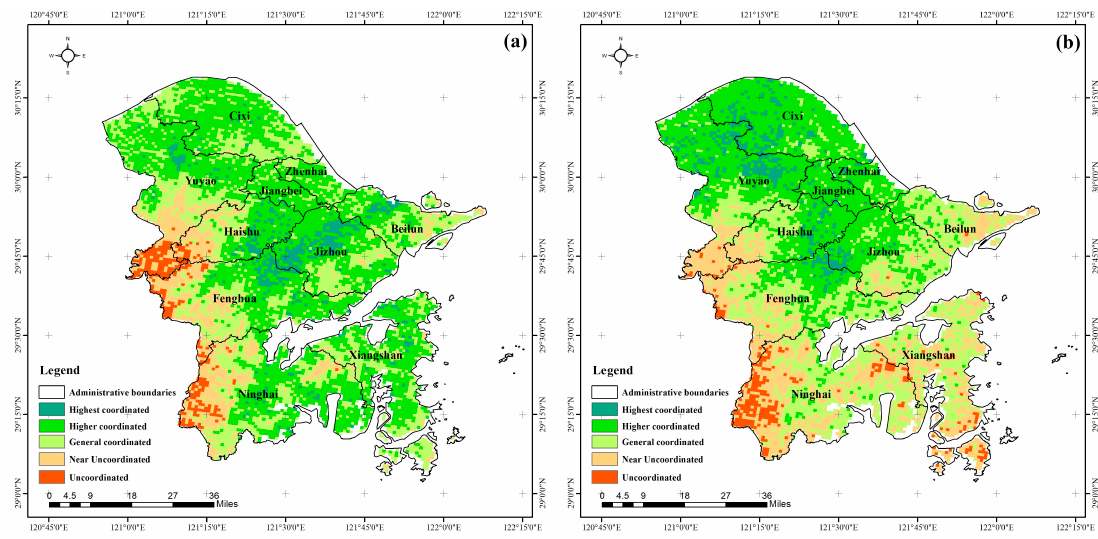
Figure 3. Coupling coordination degree of PLES suitability in Ningbo for ( a ) 2010 and ( b ) 2018.